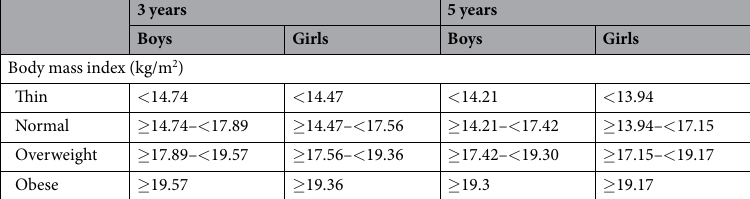
Table 1. International body mass index cut-off values by age and